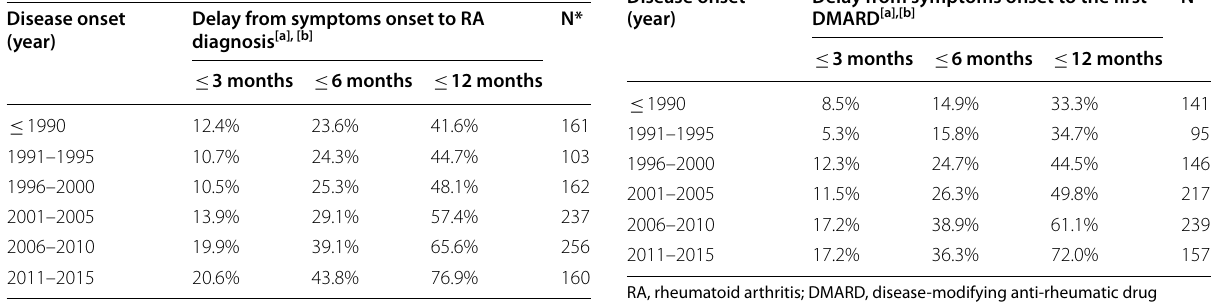
Table 1 Frequencies of early RA diagnosis in Brazil according to the year of disease onset